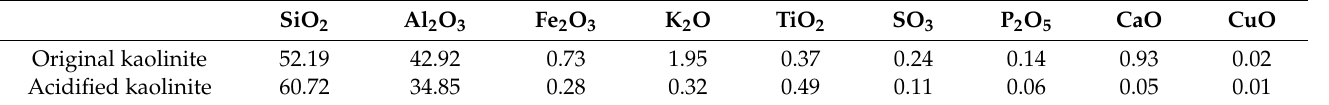
Figure 2. XRD patterns of ( a ) original kaolinite; ( b ) acidified kaolinite; ( c ) the Kac–kaolinite complex; ( d ) the FA–kaolinite complex and ( e ) the DMSO–kaolinite complex. The intercalation efficiency ( E i ) is proposed in order to compare the d 001 intensities of Table 2. Composition of the original kaolinite and the acidified